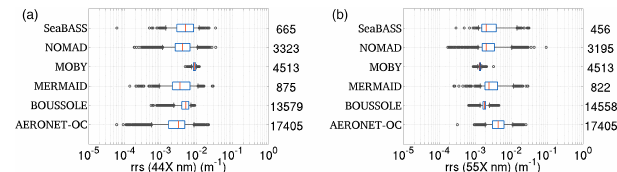
Figure 2. The distribution of (a) rrs at 44 X nm and (b) rrs at 55 X nm. Data were first searched at 445 and 555nm and then with a search window of up to 8nm to include data at 547nm. The black boxes delimit the percentiles 0.25 and 0.75 of the data and the black horizontal lines show the extension of up to the 5th and 95th per- centiles. The red line represents the median value and the black cir- cles the values below (and above) the percentile 0.05 (0.95). The number of measurements of each dataset is reported on the right axis of the graph.